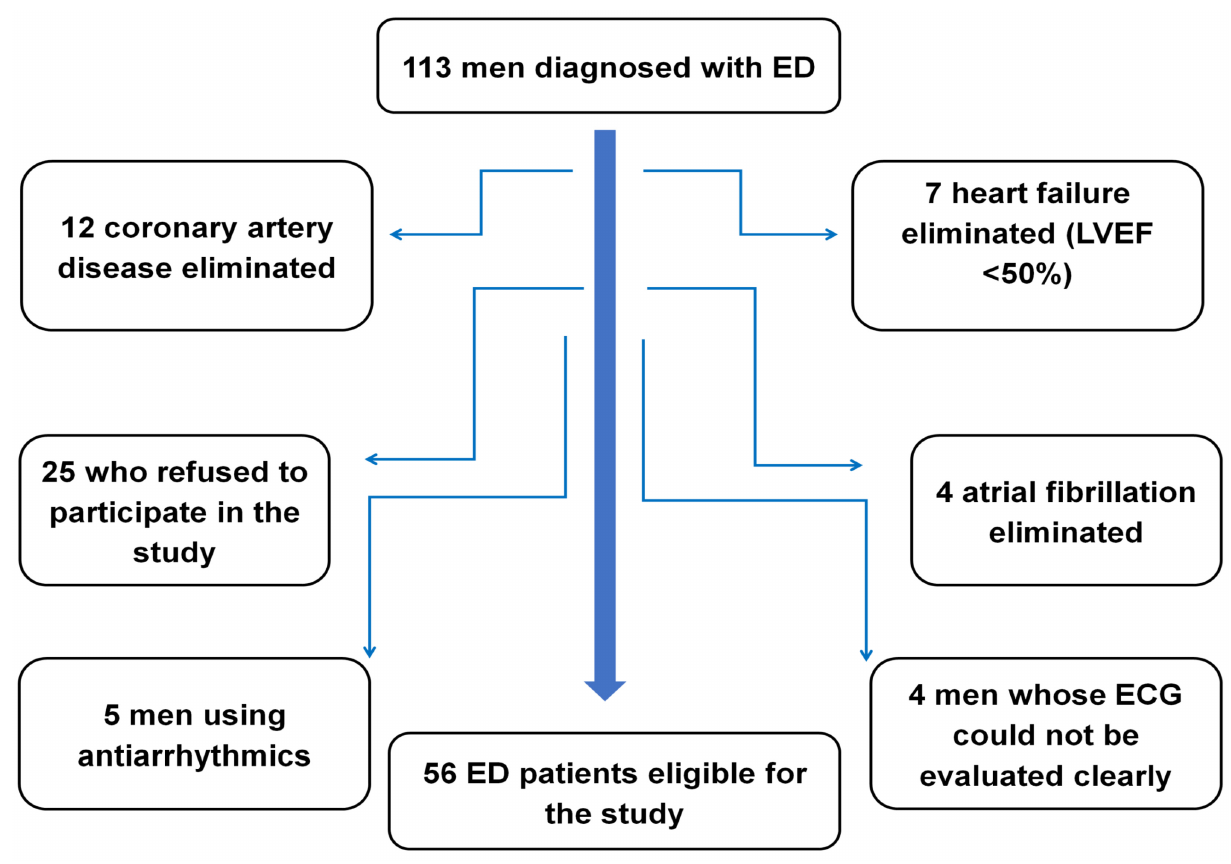
Fig. 1. Patient recruitment